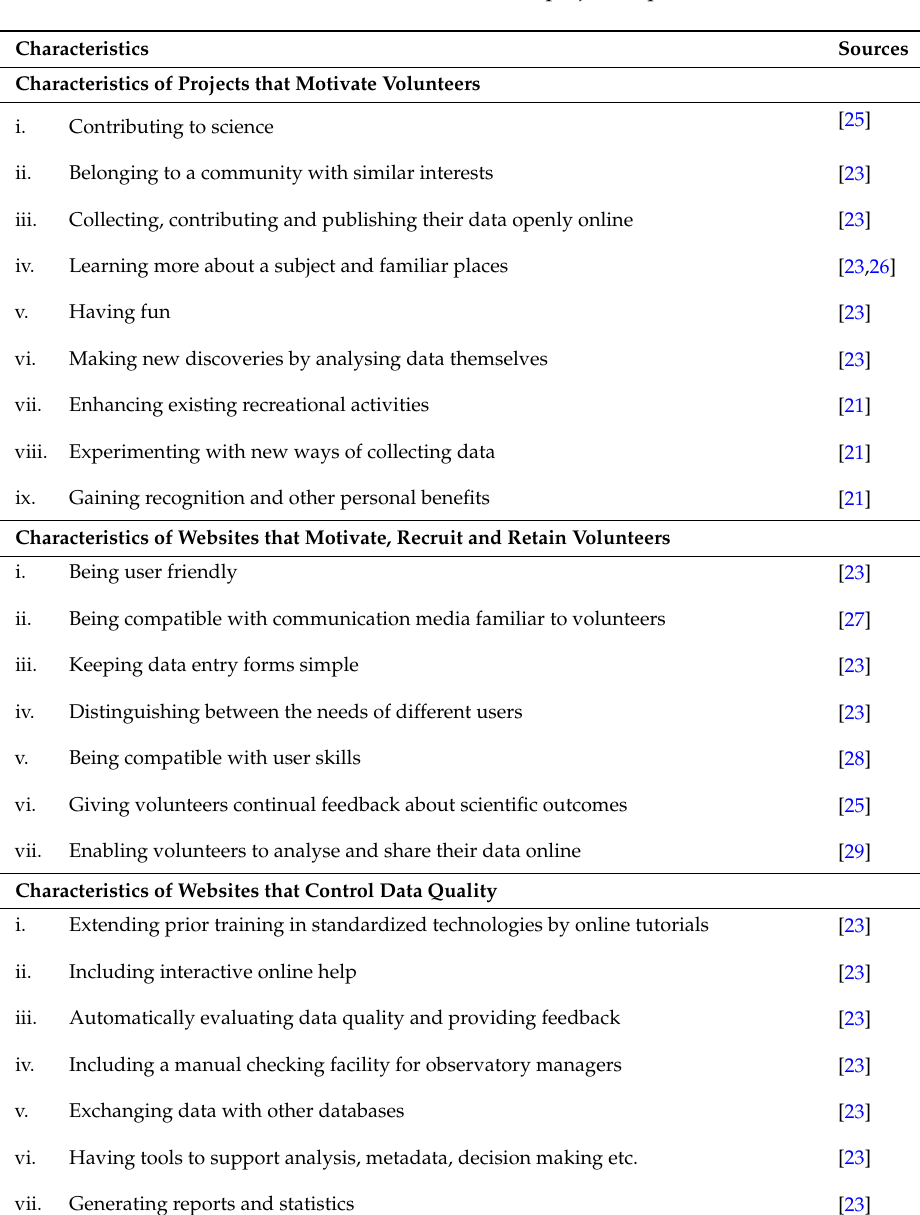
Table 1. Characteristics of effective citizen science projects reported in the